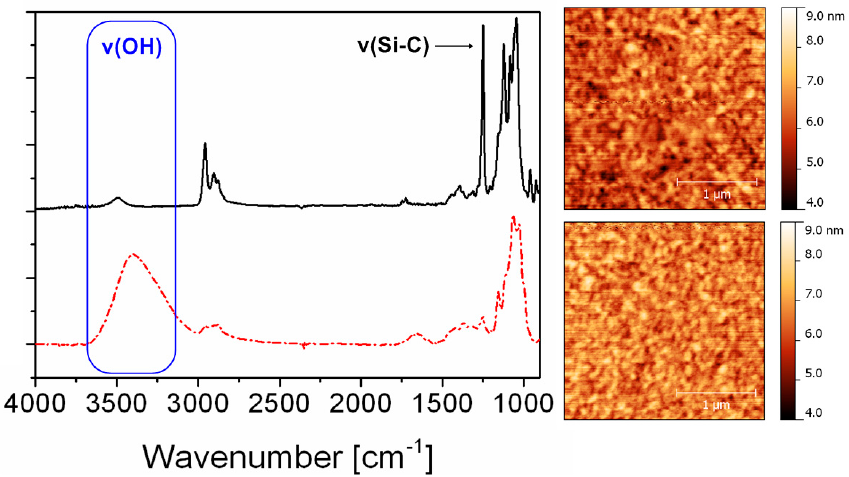
Figure 1. Comparison of IR spectra (transmission) and AFM images (scan size 2.5 × 2.5 μ m 2 ) before (upper row) and after photoregeneration of TMSC thin films containing 2 wt % of